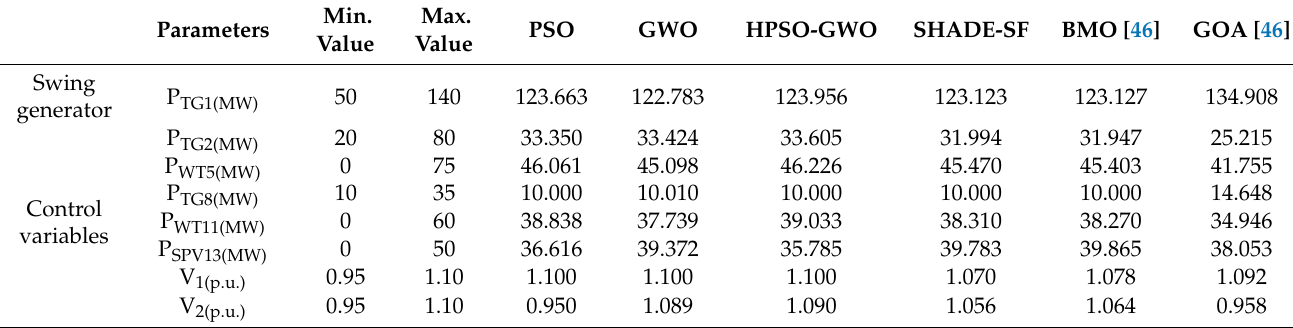
Table 7. Simulation results for Case